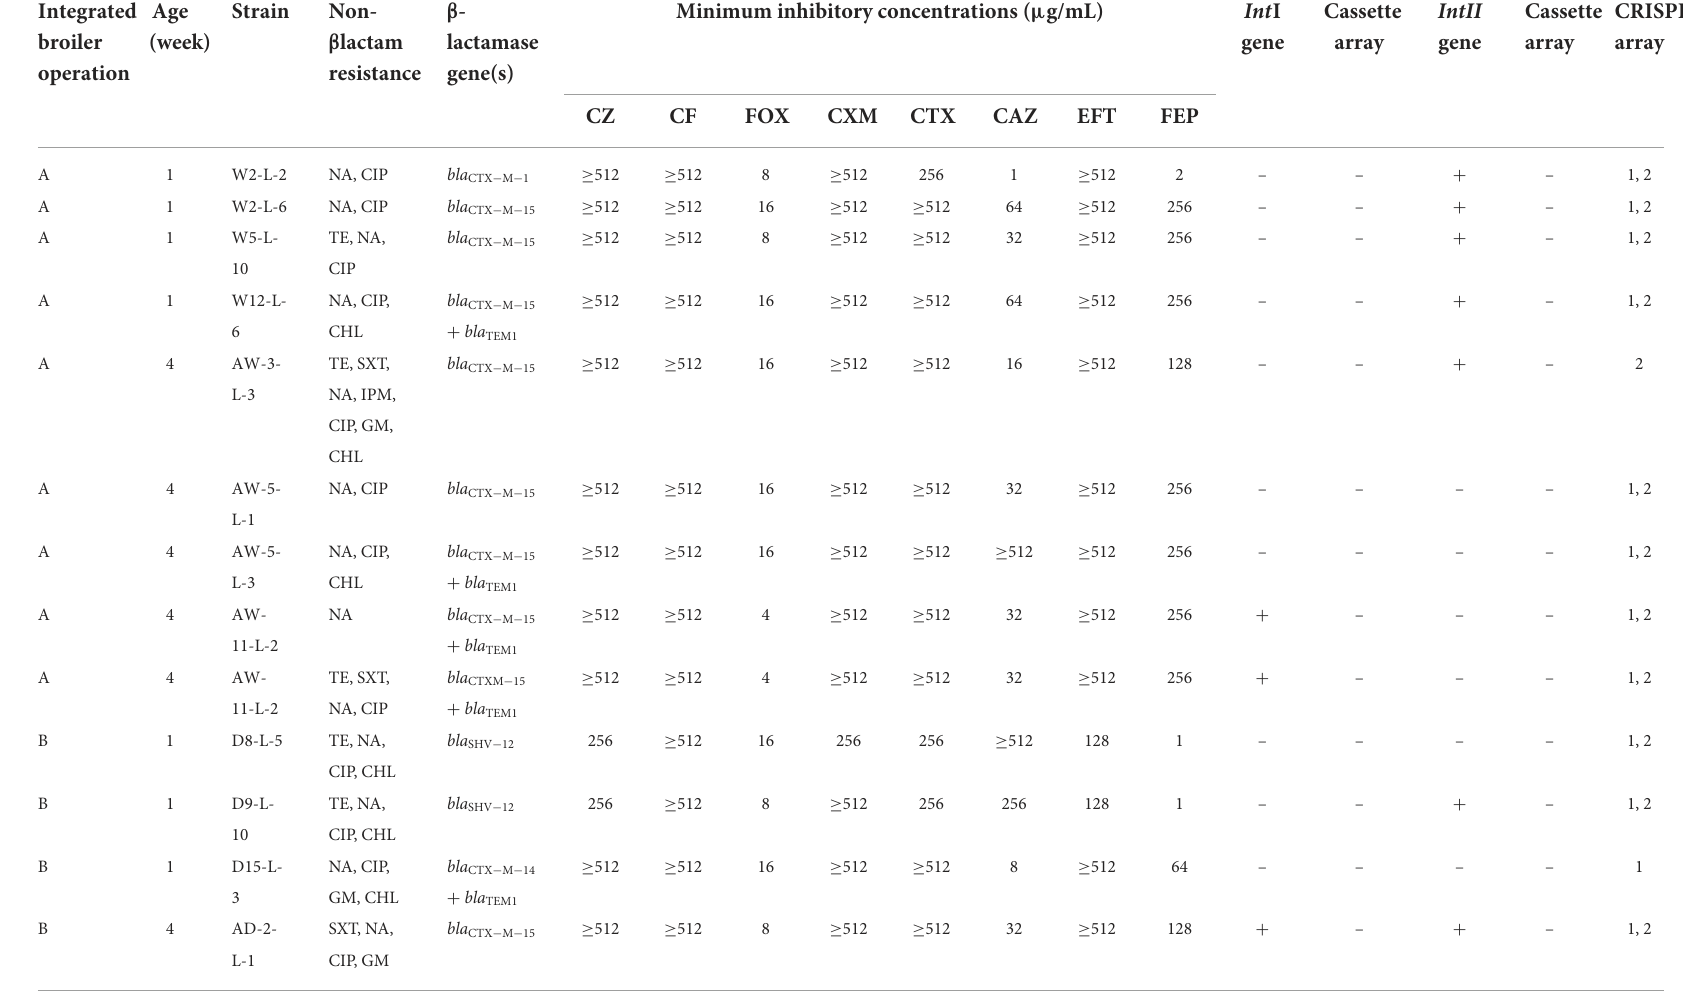
TABLE 2 Characteristics of the 49 third- or fourth- generation cephalosporin-resistant avian pathogenic E. coli from five integrated broiler